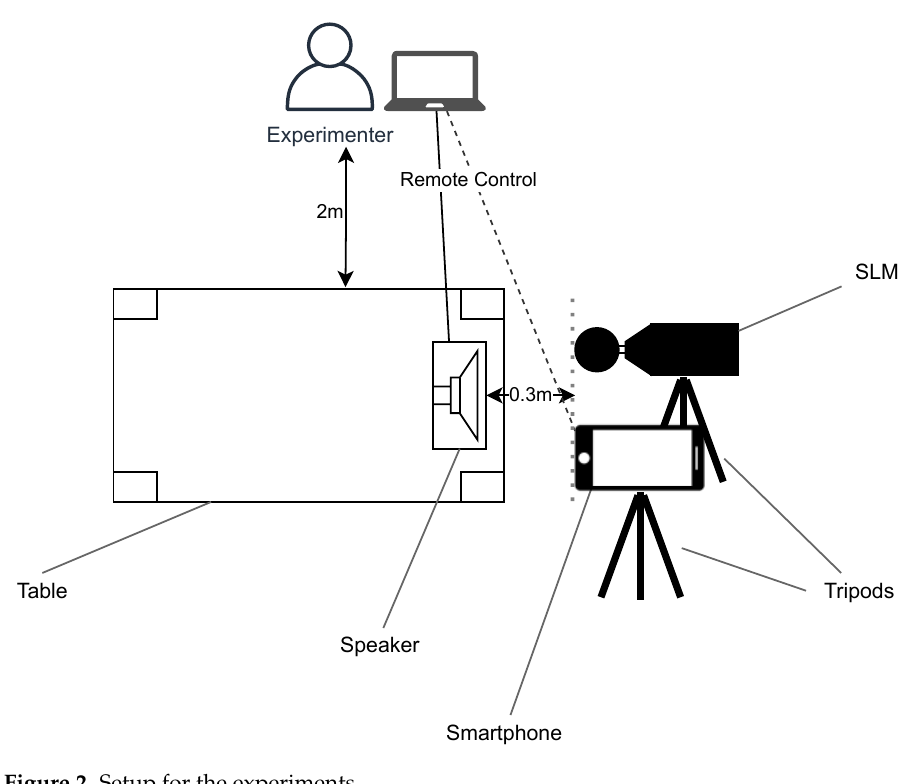
Figure 2. Setup for the